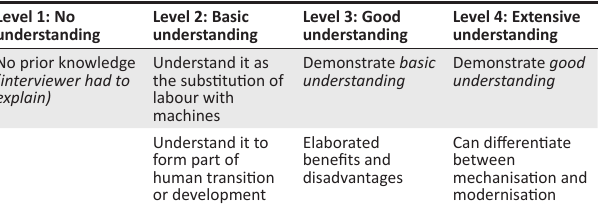
TABLE 1: Levels of understanding mechanisation and modernisation. Level 1: No